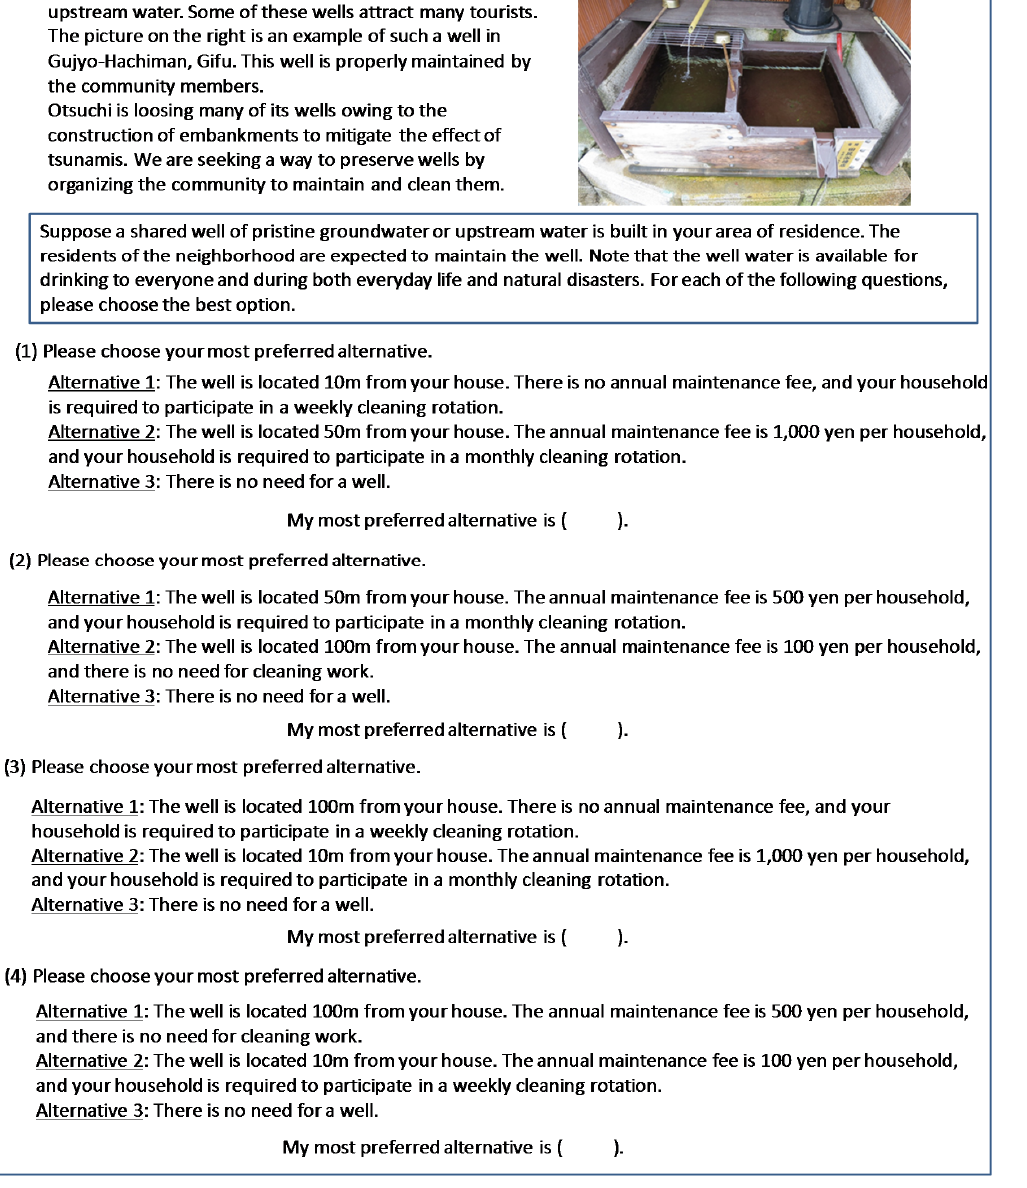
Figure 2. Example of choice question.